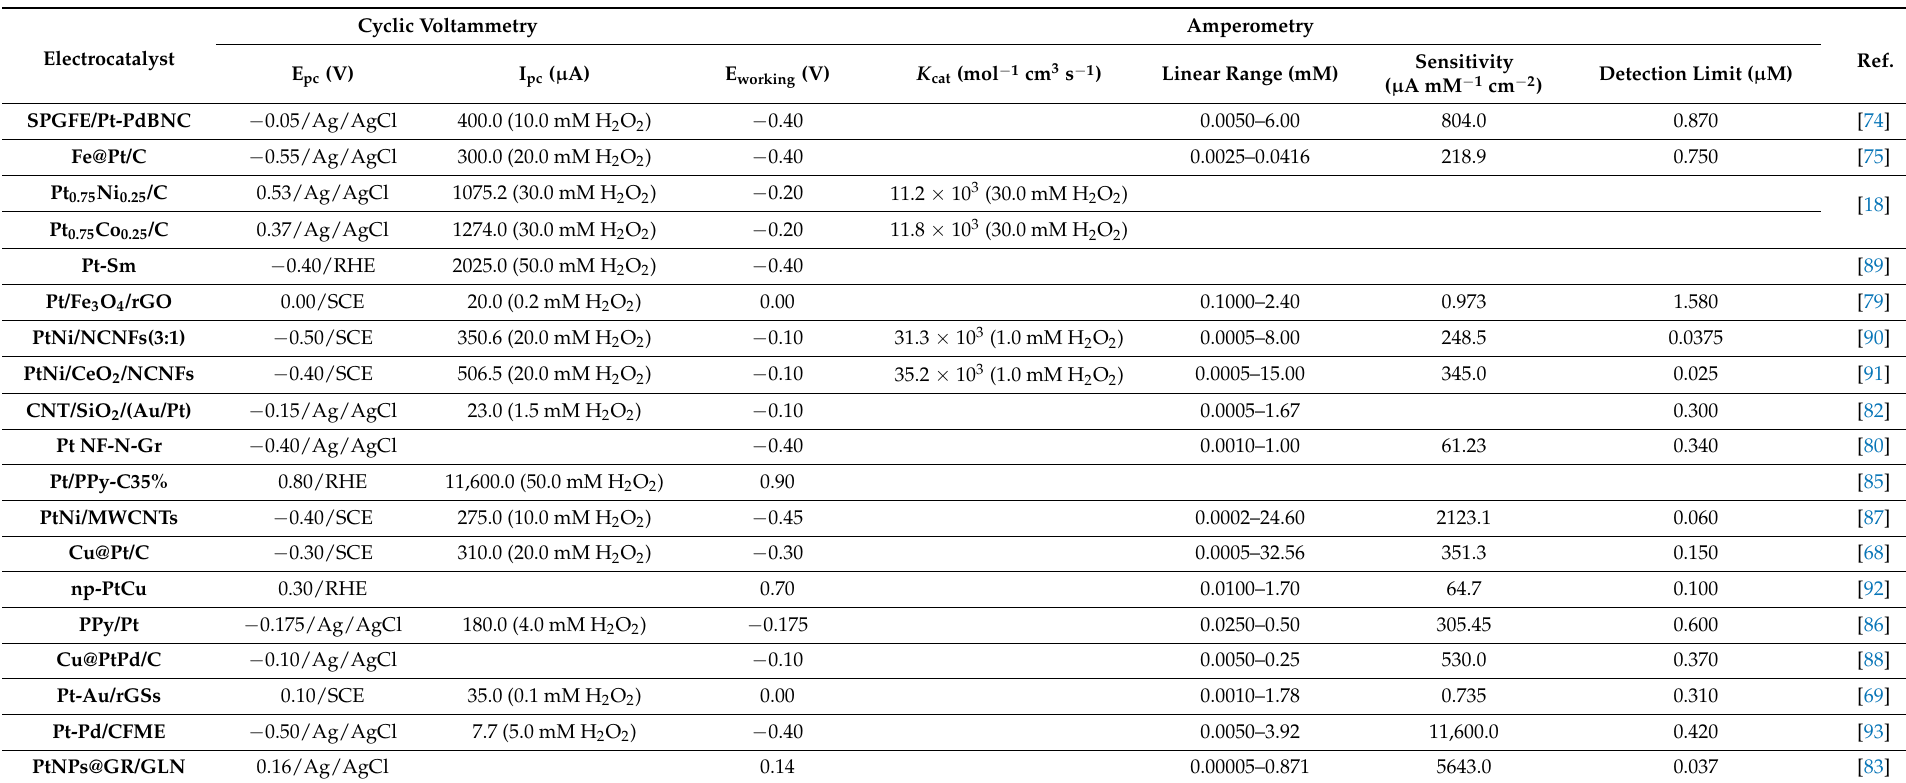
Table 1. Summary of main literature analytical parameters of various Pt-based alloy/bimetallic catalysts towards the electrochemical reduction of H 2 O 2